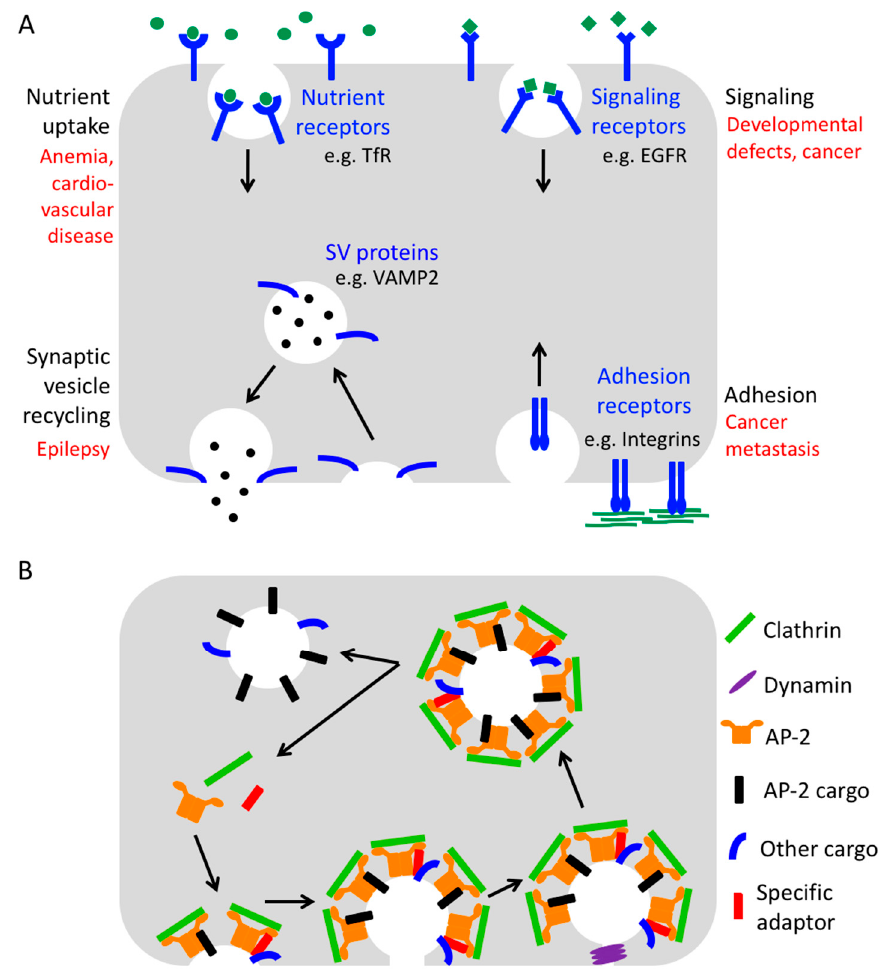
Figure 1. The process of endocytosis. ( A ) Physiological importance of endocytosis for various cellular pathways. Pathological consequences of endocytic defects affecting the different processes are depicted in red. ( B ) Simplified scheme of Clathrin-mediated endocytosis (B).